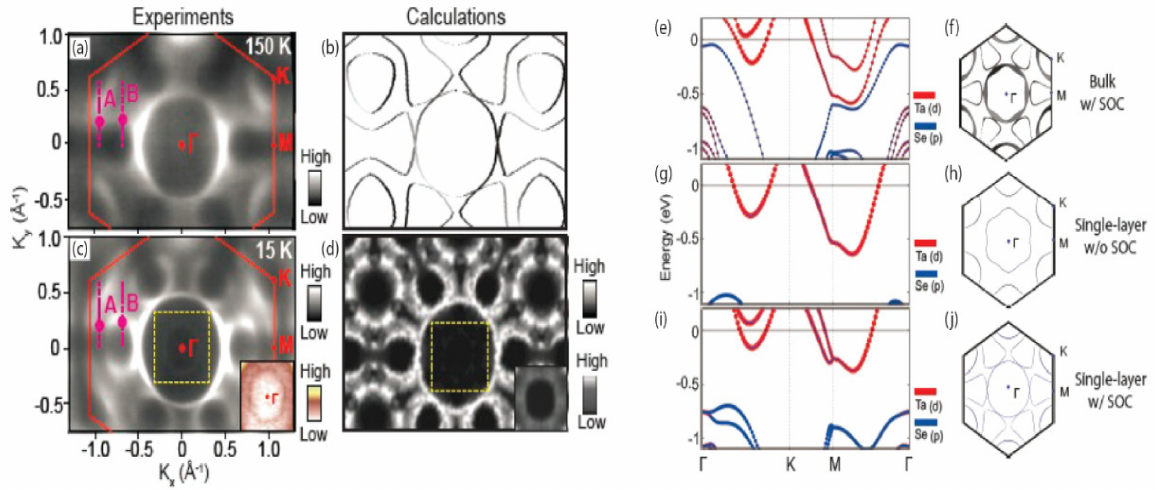
Figure 10. Electron-band structure and Fermi surface of TaSe 2 . ( a ) ARPES and ( b ) calculated Fermi surface map in the normal state (150 K). ( c ) ARPES and ( d ) calculated Fermi surface for the CDW state (15 K). Solid lines in panels ( a , c ) mark the 2D Brillouin zone of TaSe 2 . Insets at the right bottom corner in ( c , d ) are the region marked by yellow dotted square around Γ with different color scales. Calculated band structure and Fermi surface of normal-state TaSe 2 in its ( e , f ) bulk form with SOC, ( g , h ) monolayer form without SOC, and ( i , j ) monolayer form with SOC. Reprinted with permission from Reference [130]. Copyright 2018 by the American Chemical